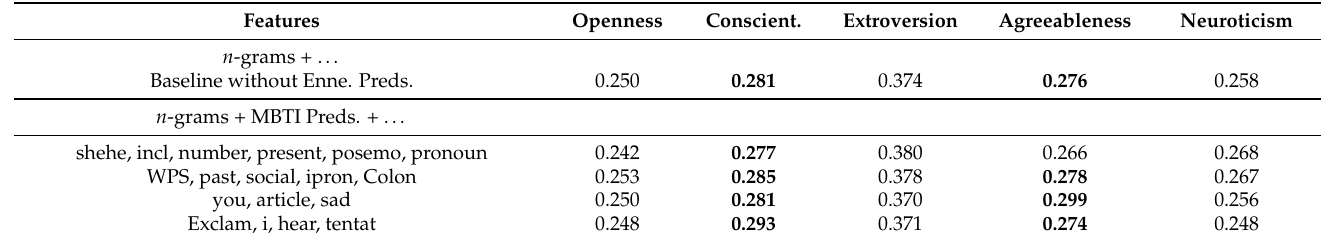
Table 14. The Pearson correlation coefficient between the gold-standard Big Five labels and predictions achieved through using n -grams, MBTI predictions and selected LIWC dimensions in the feature set with the Enneagram predictions omitted. LIWC dimensions selected for each MBTI type follow the same order described in Table 13 (e.g., from top to bottom: (1) E-I , (2) S-N , (3) T-F and (4) J-P )). Features Openness Conscient. Extroversion